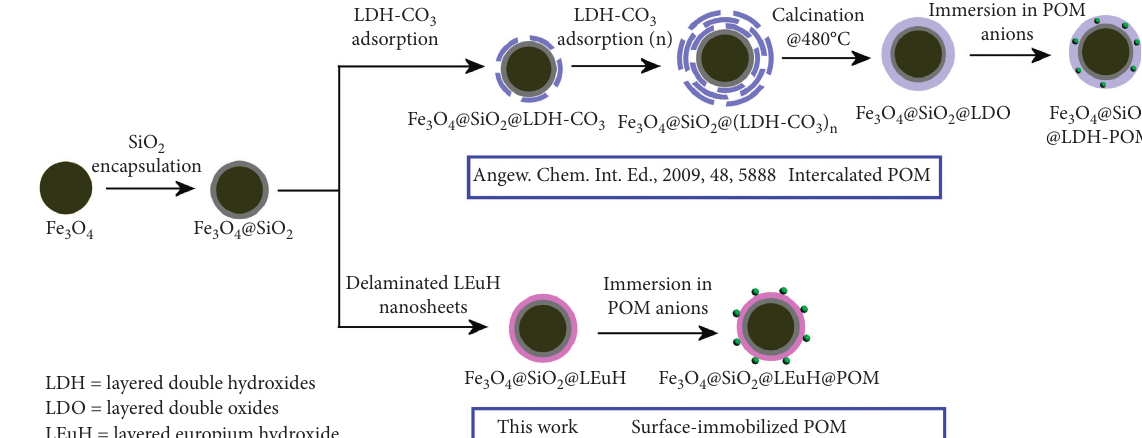
Figure 1: Comparisons between the new proposed synthetic pathway of fabricating layered rare-earth hydroxide nanosheets with POMs and literature